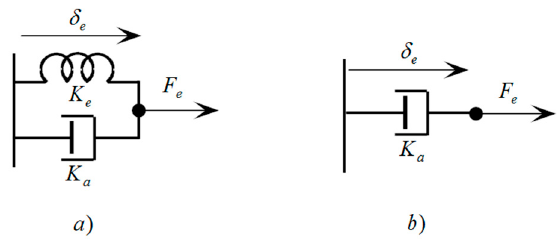
Figure 30. Virtual impedances: ( a ) spring-damper, ( b ) damper.